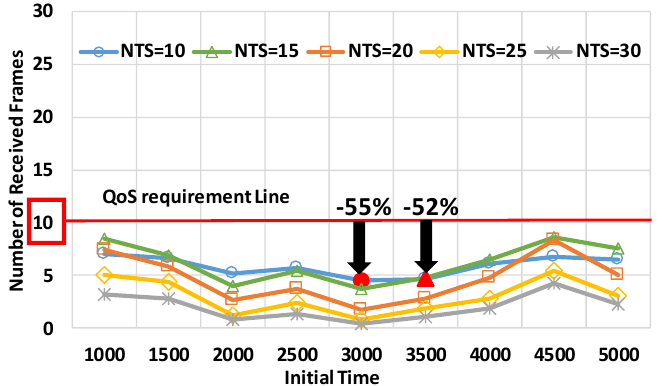
Sensors 2020 , 20 , x FOR PEER REVIEW Figure 10. The number of received frames in the large intersection. Figure 10. The number of received frames in the large intersection.